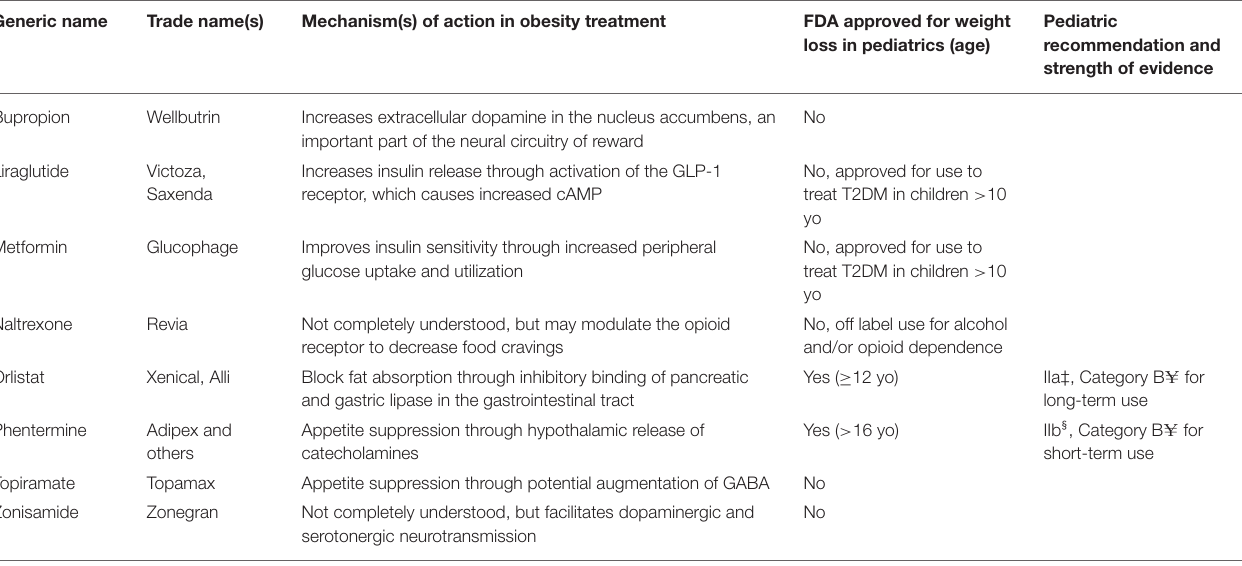
TABLE 1 | Weight-loss medications commonly prescribed to children, adolescent, and young adults with obesity (31,